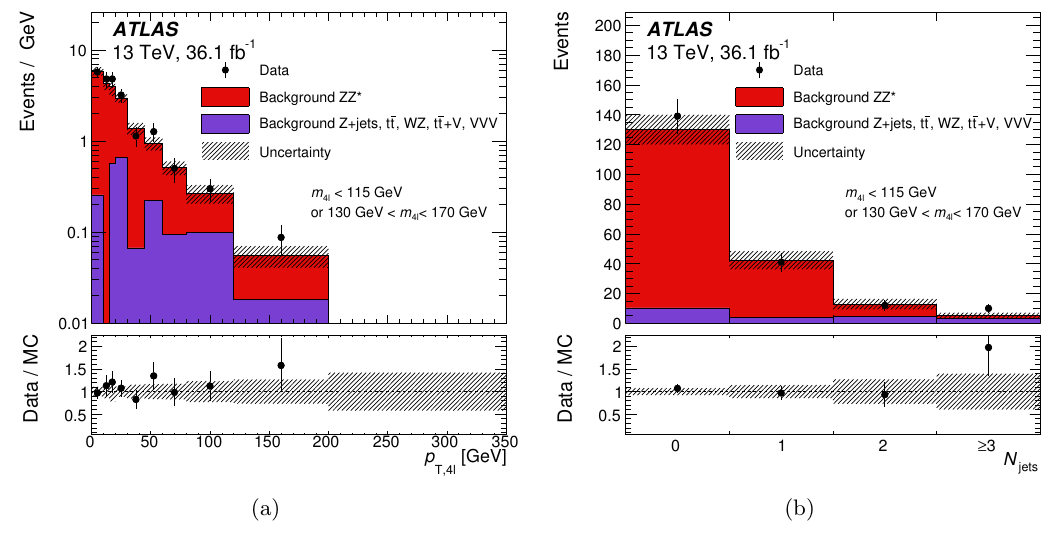
Figure 2. Reconstructed event yields in bins of (a) the transverse momentum of the four lep- tons p T ; 4 ‘ and (b) the number of jets N jets , in a non-resonant ZZ (cid:3) -enriched control region, ob- tained by applying the full event selection except for the m 4 ‘ window, i.e. m 4 ‘ < 115 GeV or 130 GeV < m 4 ‘ < 170 GeV. The error bars on the data points indicate the statistical uncertainty. The uncertainty in the prediction is shown by the dashed band. The bottom part of the (cid:12)gures shows the ratio of data to the MC